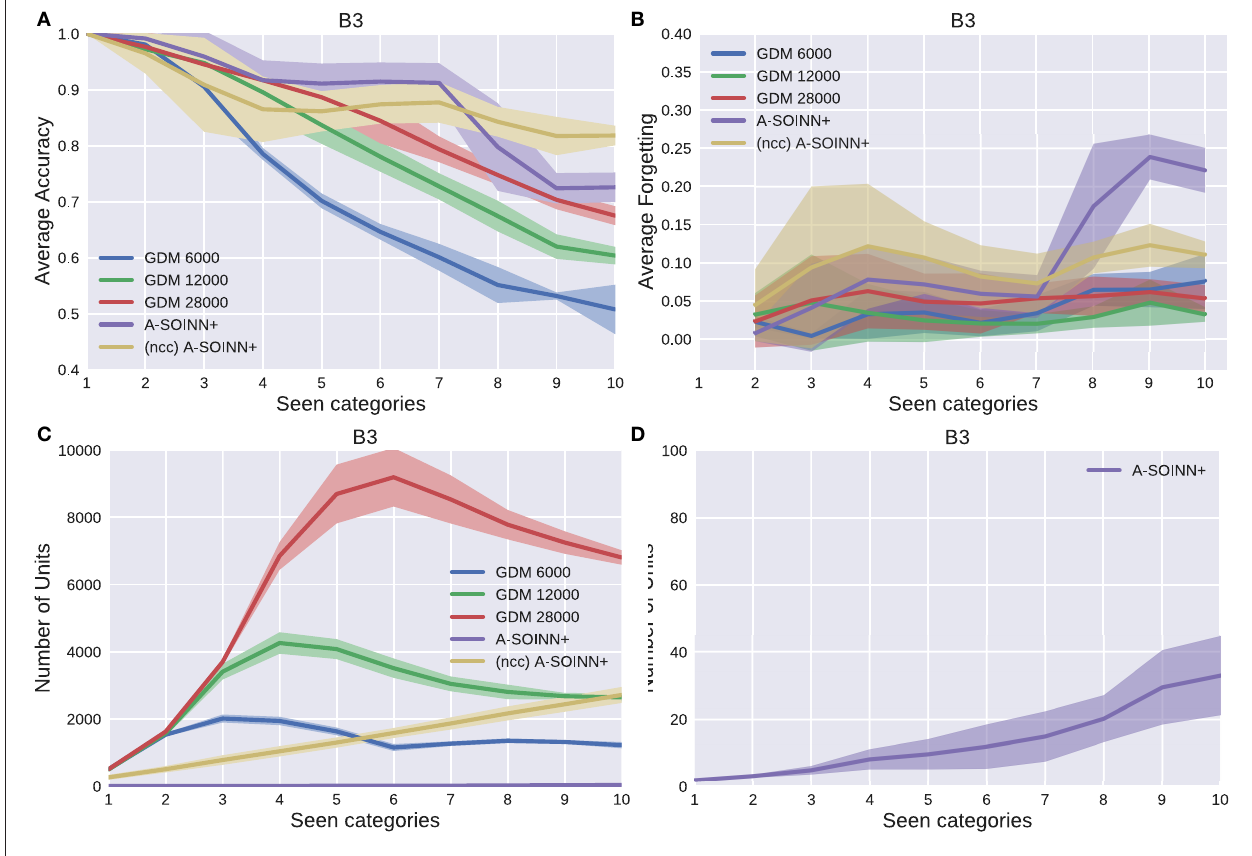
FIGURE 7 | The results of the third experiment. For further descriptions, see Figure 5